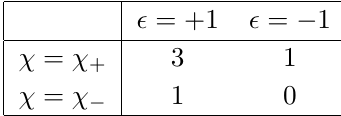
Table 2 . The number of Z 2 × Z 2 self-dual SPT phases with time-reversal